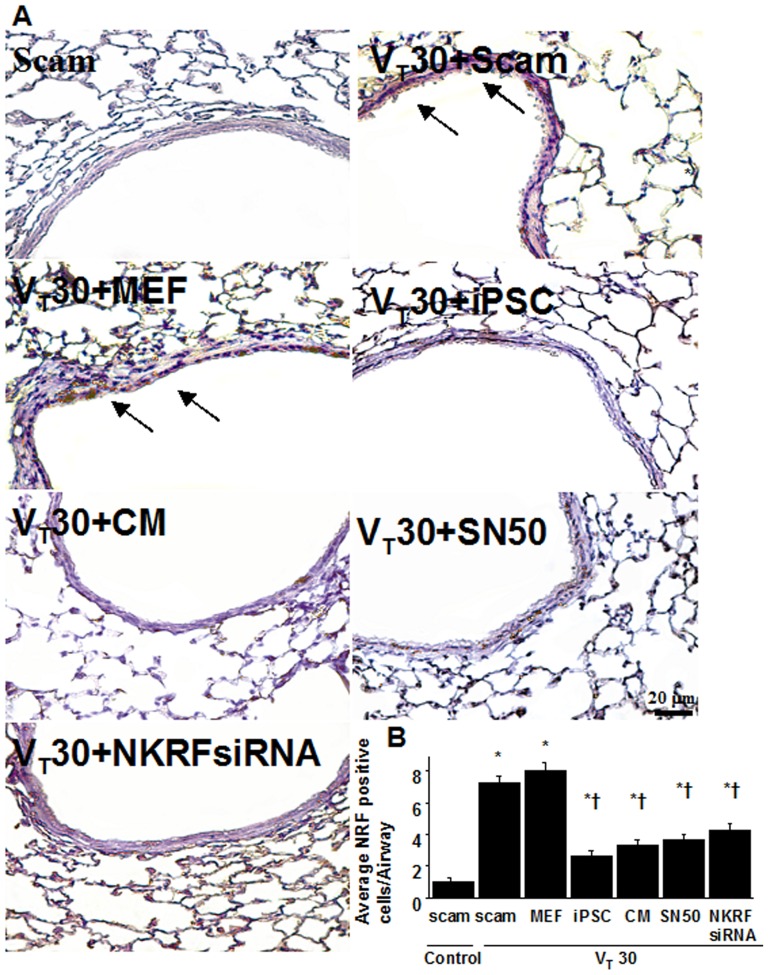
iPSCs or iPSC-CM, SN50, or NKRF siRNA abrogated lung stretch-induced NKRF expression in airway epithelium.Immunohistochemistry (A, ×400) and quantification (B) of NKRF expression were from the lungs of VT30-ventilated wild-type mice receiving iPSCs, iPSC-CM, SN50, or NKRF siRNA. Data shown here are representative results of five independent experiments. A dark brown diaminobenzidine signal identified by arrows indicates positive staining for NKRF in the lung epithelium or interstitial, whereas shades of bluish tan signify nonreactive cells. Data shown here are the mean ± SD of five independent experiments. *P<0.05 vs. Non-ventilated control treated with scam, †P<0.05 vs. VT30-ventilated mice treated with scam or MEF. Scale bars represent 20 µm.